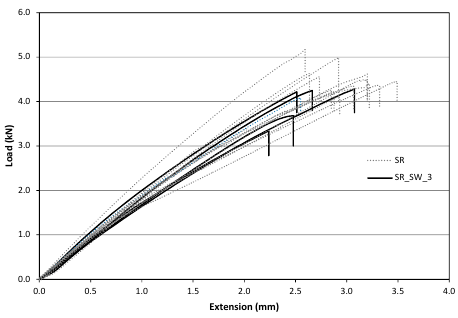
Figure 11. Comparison between SR and SR_SW_3.